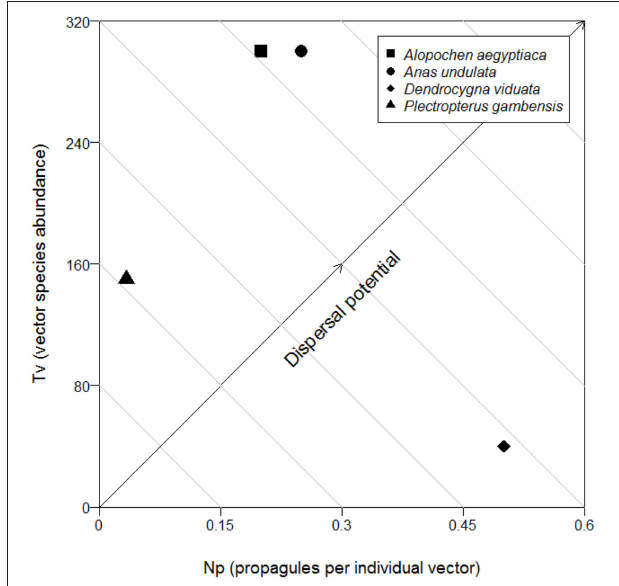
FIGURE 2 | Biplot showing the Relative Dispersal Potential potential of yellow-billed duck, A. undulata; Egyptian goose, A. aegyptiaca; white-faced duck, D. viduata; and spur-winged goose, P. gambensis, with Daphnia sp. propagules. The red-billed teal, A. erythrorhyncha, had zero Daphnia propagules and hence was omitted from the biplot. Dispersal potential increases from bottom left to top